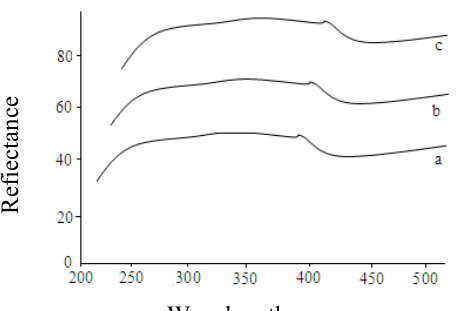
Figure 2. UV- DRS spectra of a) PbO nanoparticle, b) 3% Ni doped PbO nanoparticle, c) 7% Ni doped PbO nanoparticle.